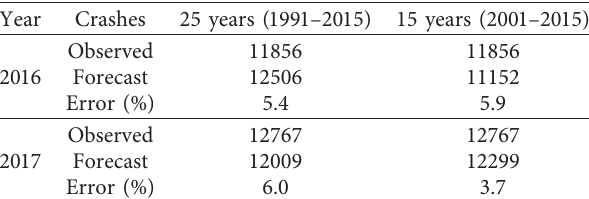
Table 8: The forecast error of the best-fit models for Palestine for 2016 and